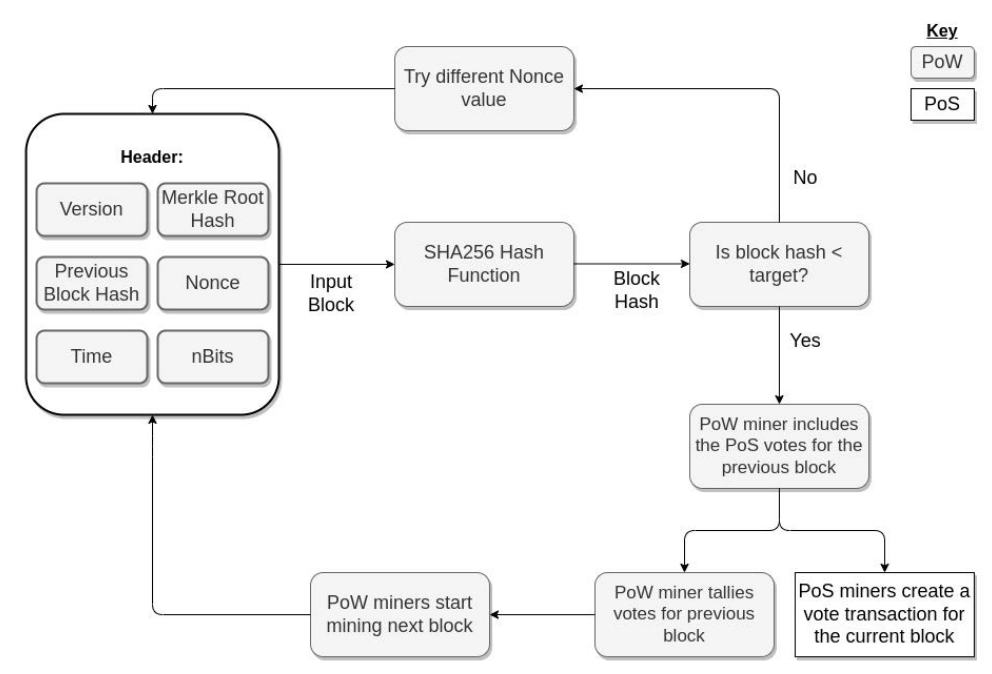
Figure 13. Decred’s hybrid PoW/PoS consensus mechanism. Table 1. Overview of all the consensus mechanisms mentioned in Sections